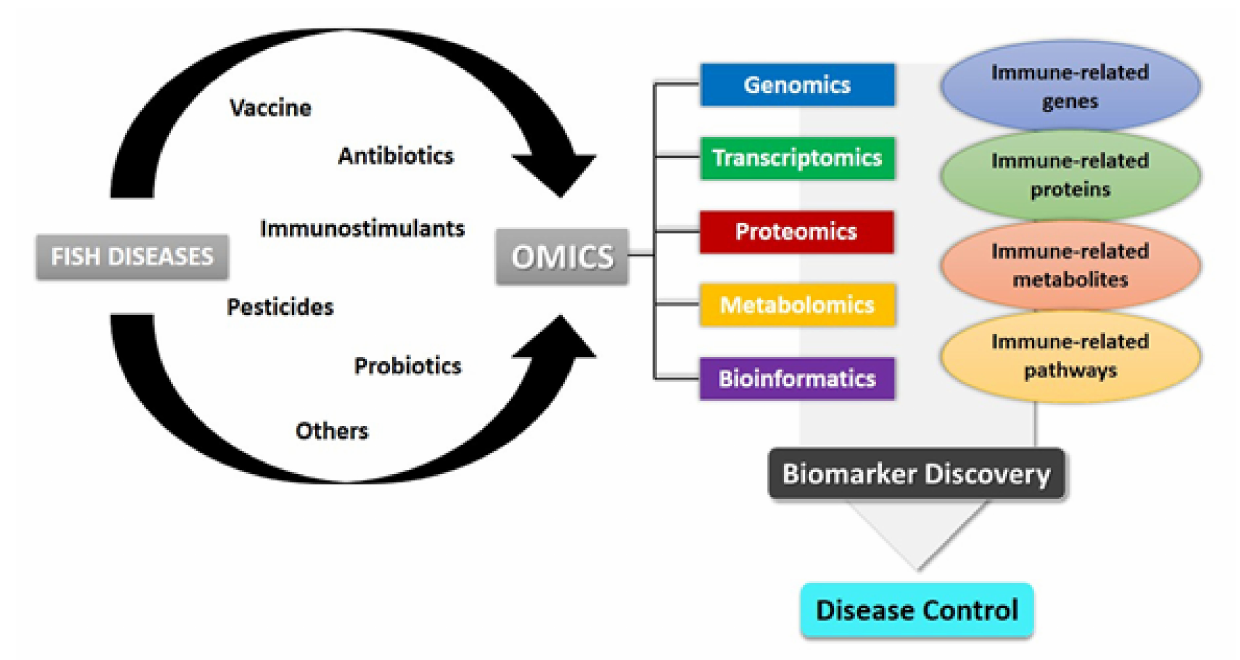
Figure 1. Applications of omics in the current technologies available for fish